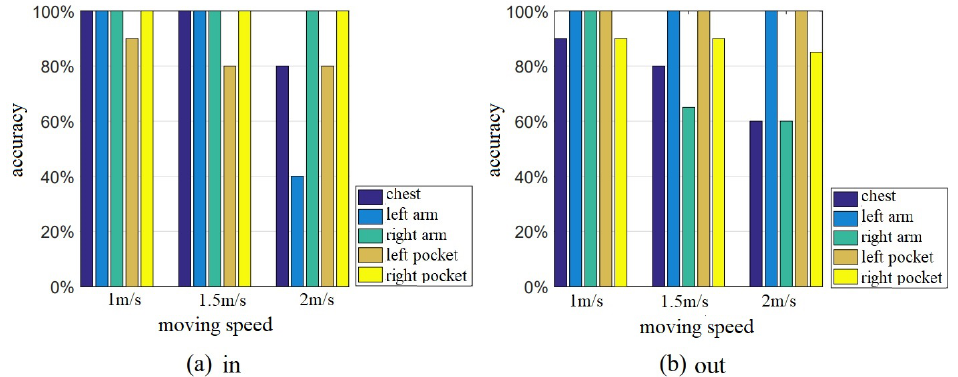
Figure 14. Detection accuracy of signal-based sensing